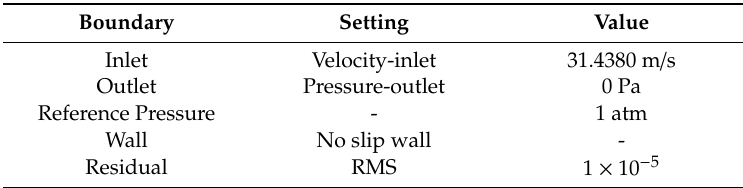
Table 2. Boundary conditions.